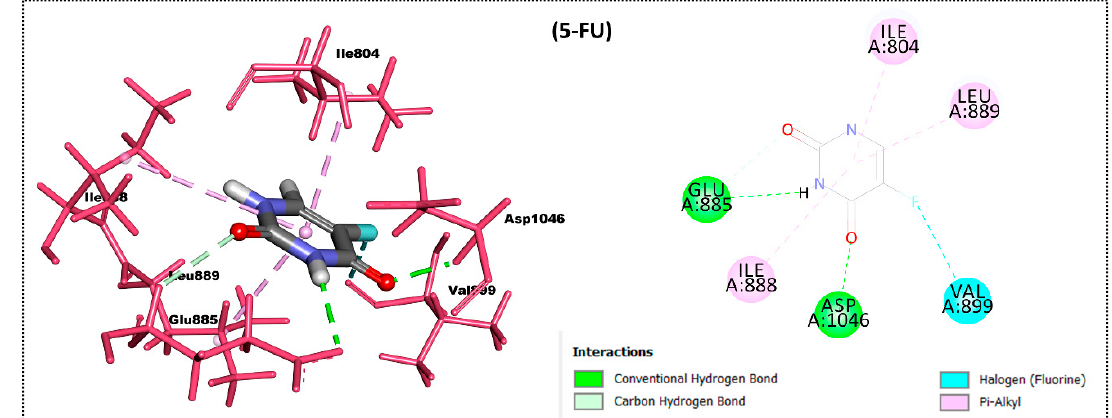
Figure 3. Docking interactions (3D & 2D) of reference drug 5-FU with the receptor protein, VEGFR-2 transferase. Critical amino acid residues are shown in the stick model and pink colour.